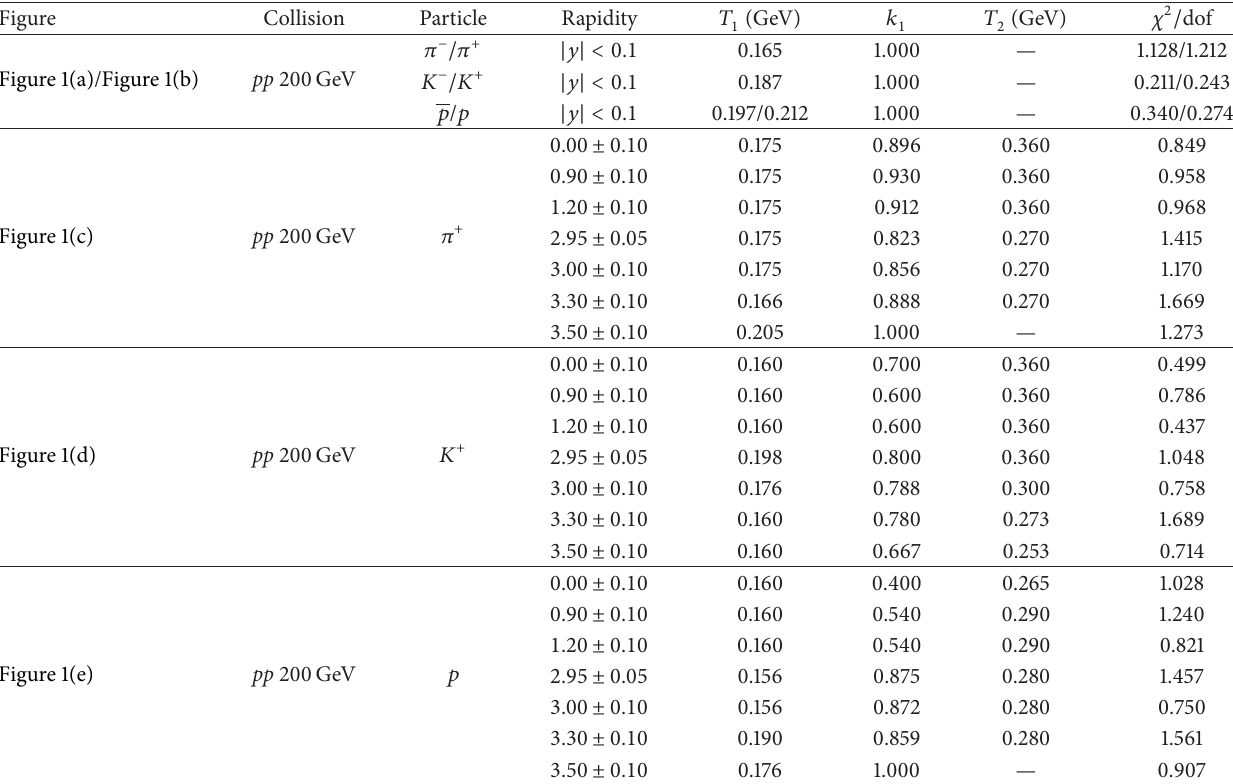
Table 1: Parameter values corresponding to the curves in Figure 1. Figure Collision Particle Rapidity Figure 1(a)/Figure 1(b)